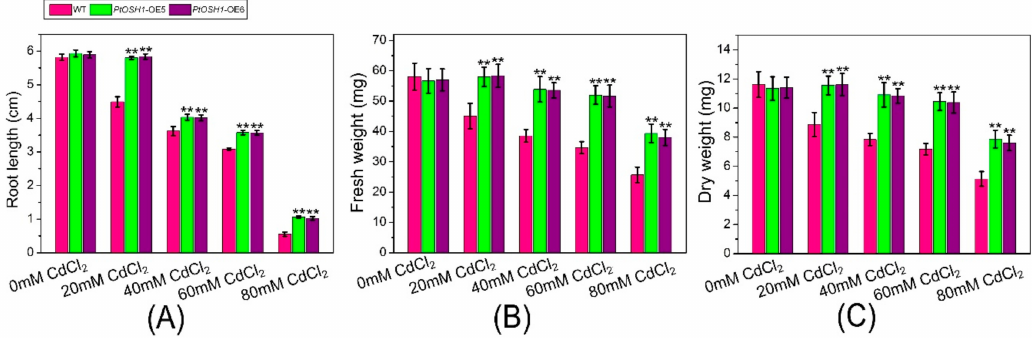
Figure 6. Tolerance of WT A. thaliana and PtOSH1 -OE A. thaliana lines to Cd stress. ( A ) Root length of WT and PtOSH1 -OE A. thaliana lines under Cd stress. ( B ) Fresh weight of WT and PtOSH1 -OE A. thaliana lines under Cd stress. ( C ) Dry weight of WT and PtOSH1 -OE A. thaliana lines under Cd stress. Three independent biological experiments were performed. One-way ANOVA and Tukey’s test were used to evaluate significant di ff erences. Vertical bars represent the means ± SD (n = 3). **, Significant di ff erence at p <